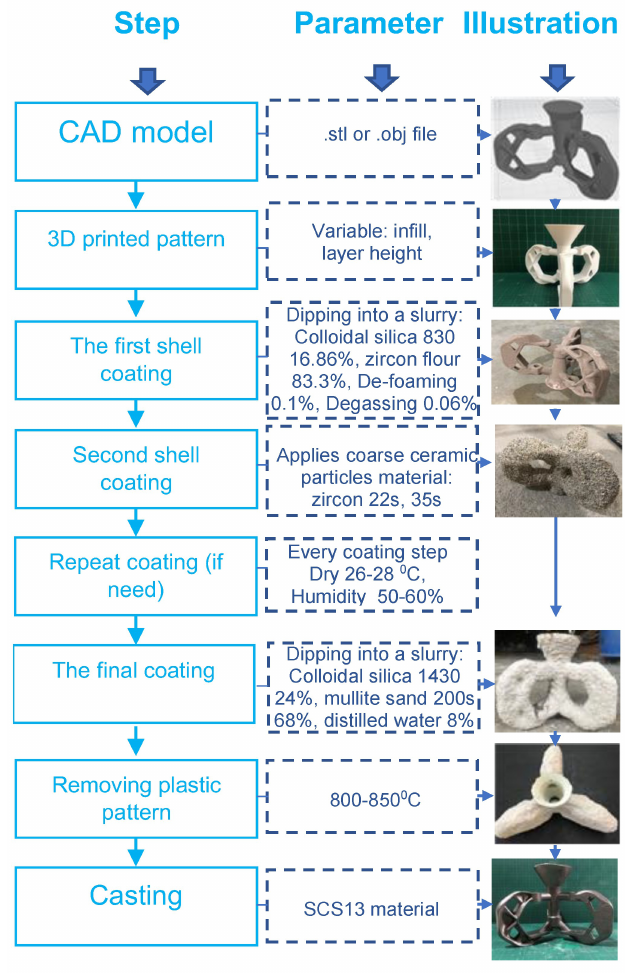
Figure 1. The process for using the plastic–printed pattern in